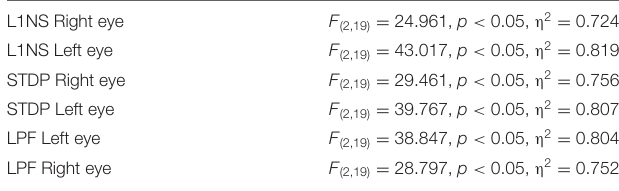
TABLE 4 | Repeated measure one-way ANOVA for each metric with an effect size.